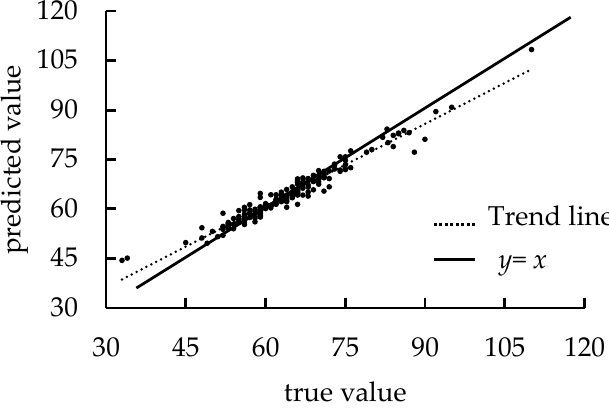
Figure 9. Fitting effect of predicted value and true value.